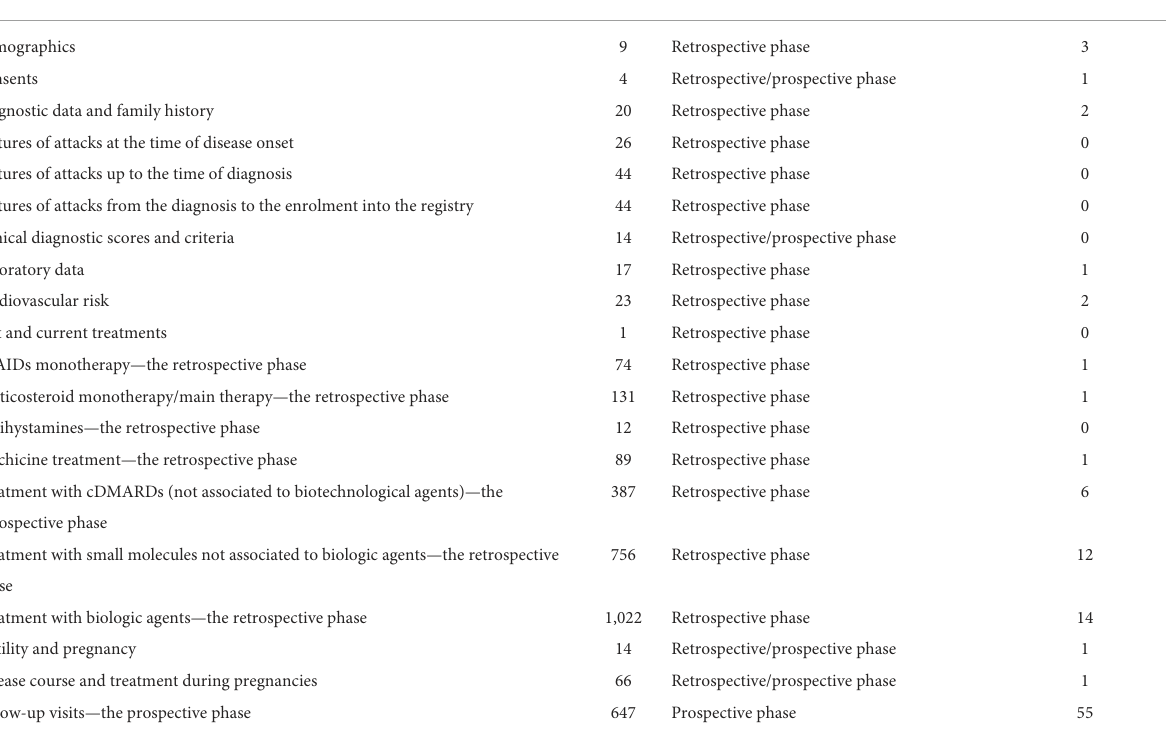
TABLE 1 List of instruments (to be regarded as “forms”) included in the registry dedicated to patients with Schnitzler’s syndrome, with the corresponding number of common data elements, time-points at which they should refer to and number of mandatory fields.